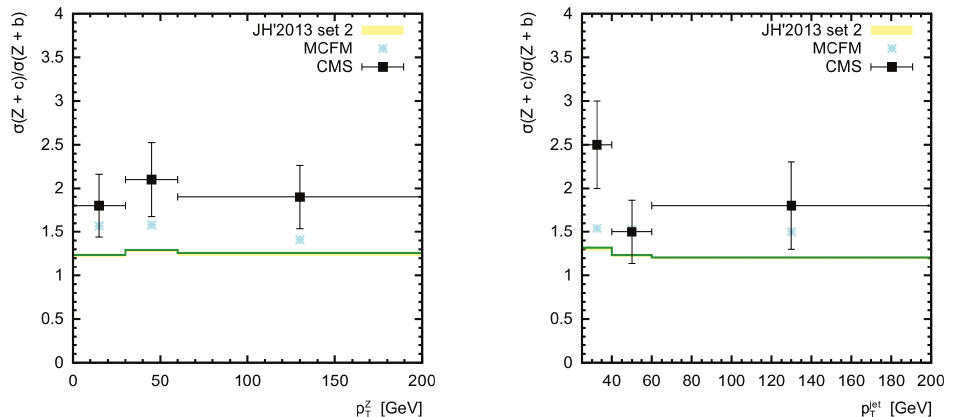
Figure 5. Associated production of a Z boson and two b -hadrons at √ s = 7 TeV under additional kinematical > 50 GeV. Notation of the histograms is the same as in Fig. 1. The cut on the Z boson transverse momentum p Z T data are from CMS [2]. The aMC@NLO [29] predictions are taken from [2]. Figure 7. The ratio σ ( Z + c ) /σ ( Z + b ) calculated as a function of Z boson and c -jet transverse momenta at √ s = 8 TeV. Notation of histograms is the same as in Fig. 1. The experimental data are from CMS showering, obtained with MadGraph event generator, are in better agreement with the data than the NLO ones, although they still slightly underestimate the CMS data. The di ff erences between these predictions and the data are reduced in the σ ( Z + c ) /σ ( Z + b ) ratios. The results of our calculations